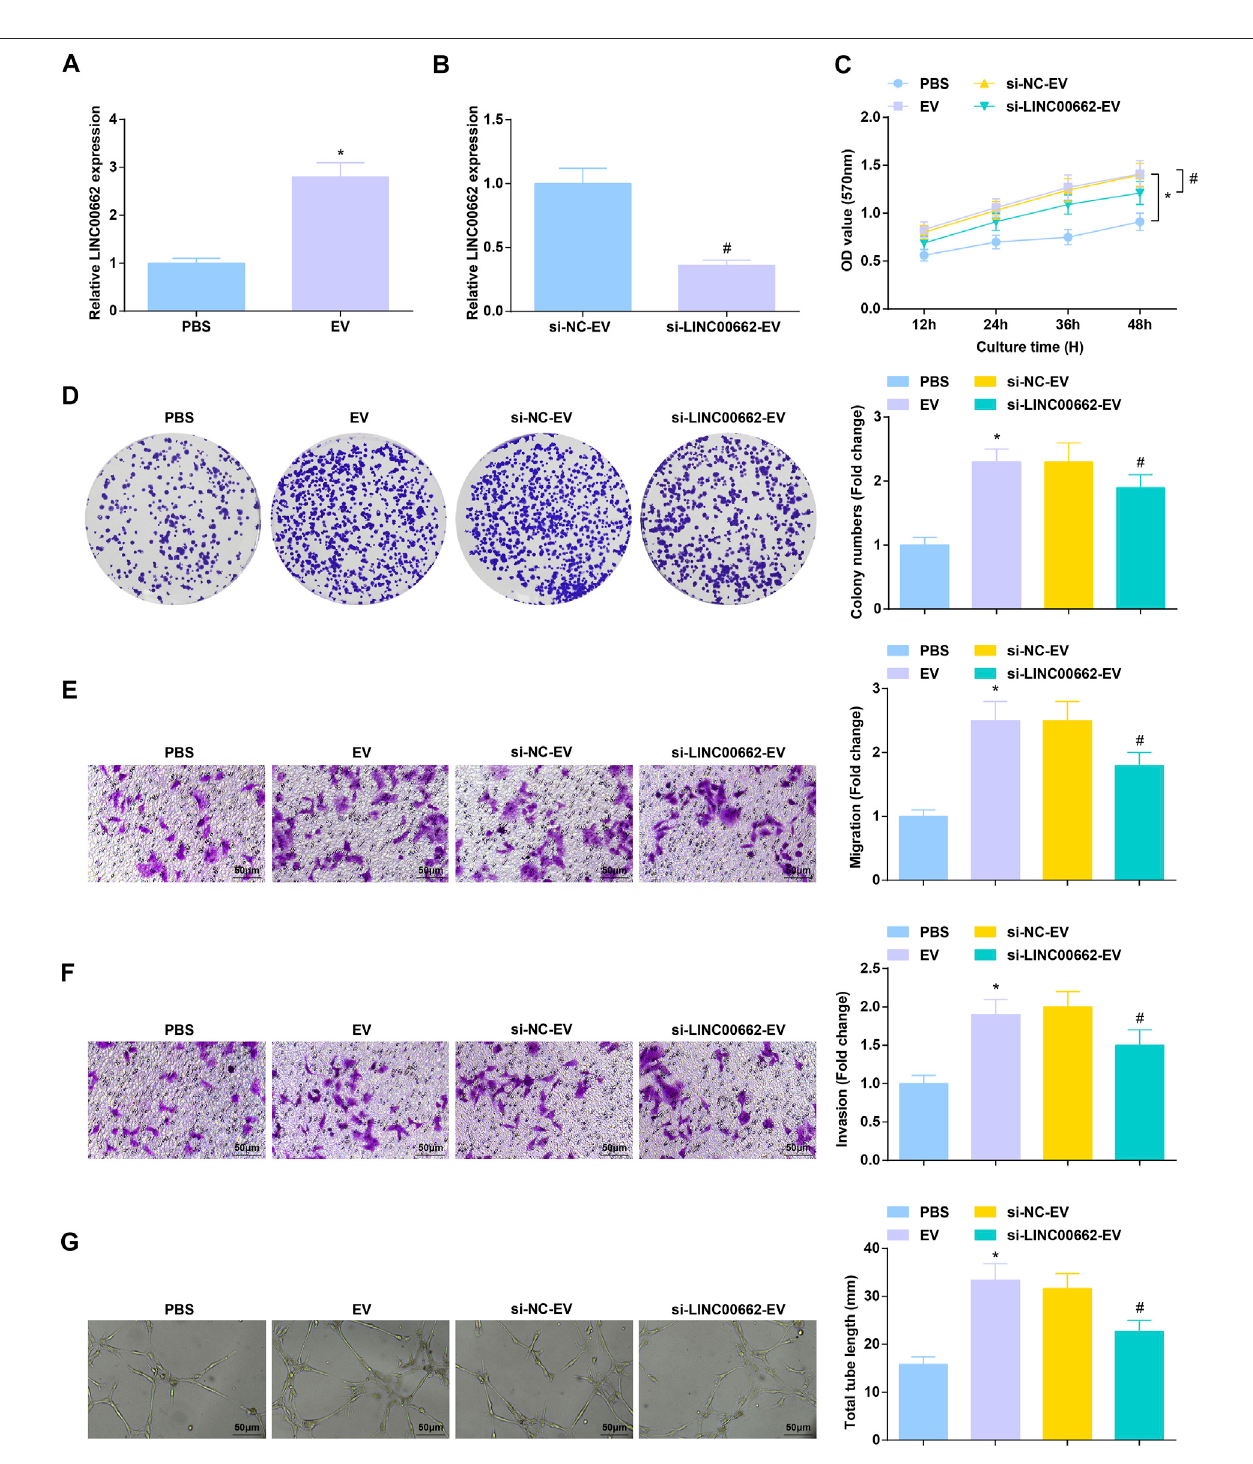
FIGURE 4 | Anti-angiogenesis effect of EVs transfer of inhibited LINC00662. (A,B) RT-qPCR detection of LINC00662 expression in HUVECs after co-culture with EVs; (C,D) ViabilityandcolonyformationabilityofHUVECsafterco-culturewithEVs; (E,F) MigrationandinvasionofHUVECsafterco-culturewithEVs; (G) Angiogenesis of HUVECs after co-culture with EVs. * p < 0.05 vs. the PBS group; # p < 0.05 vs. the si-NC-EV group.